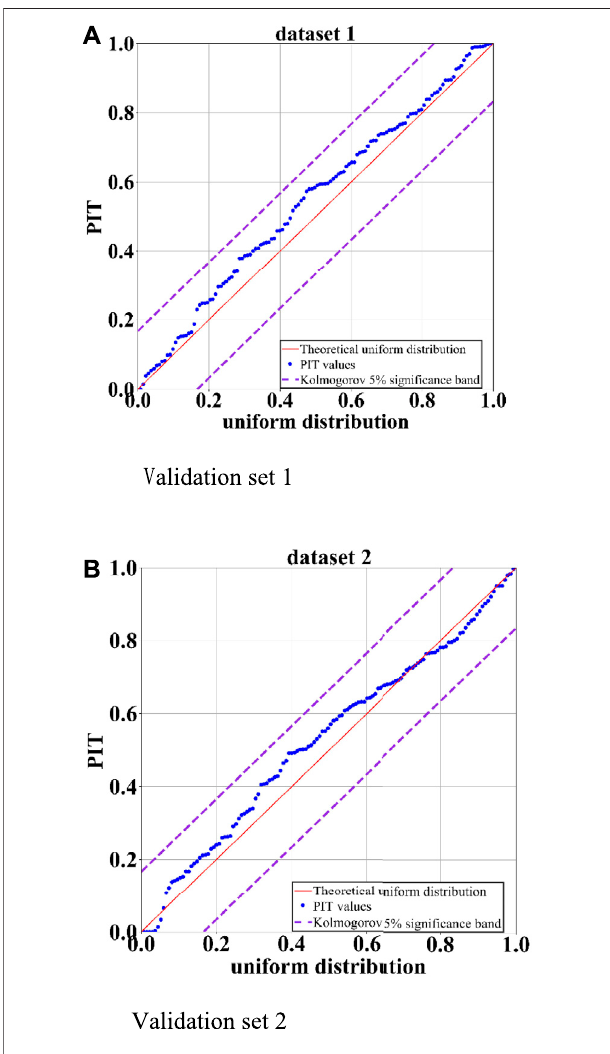
FIGURE 6 | Reliability test of beta – ARQEA – SWLSTM. (A) Validation set 1. (B) Validation set